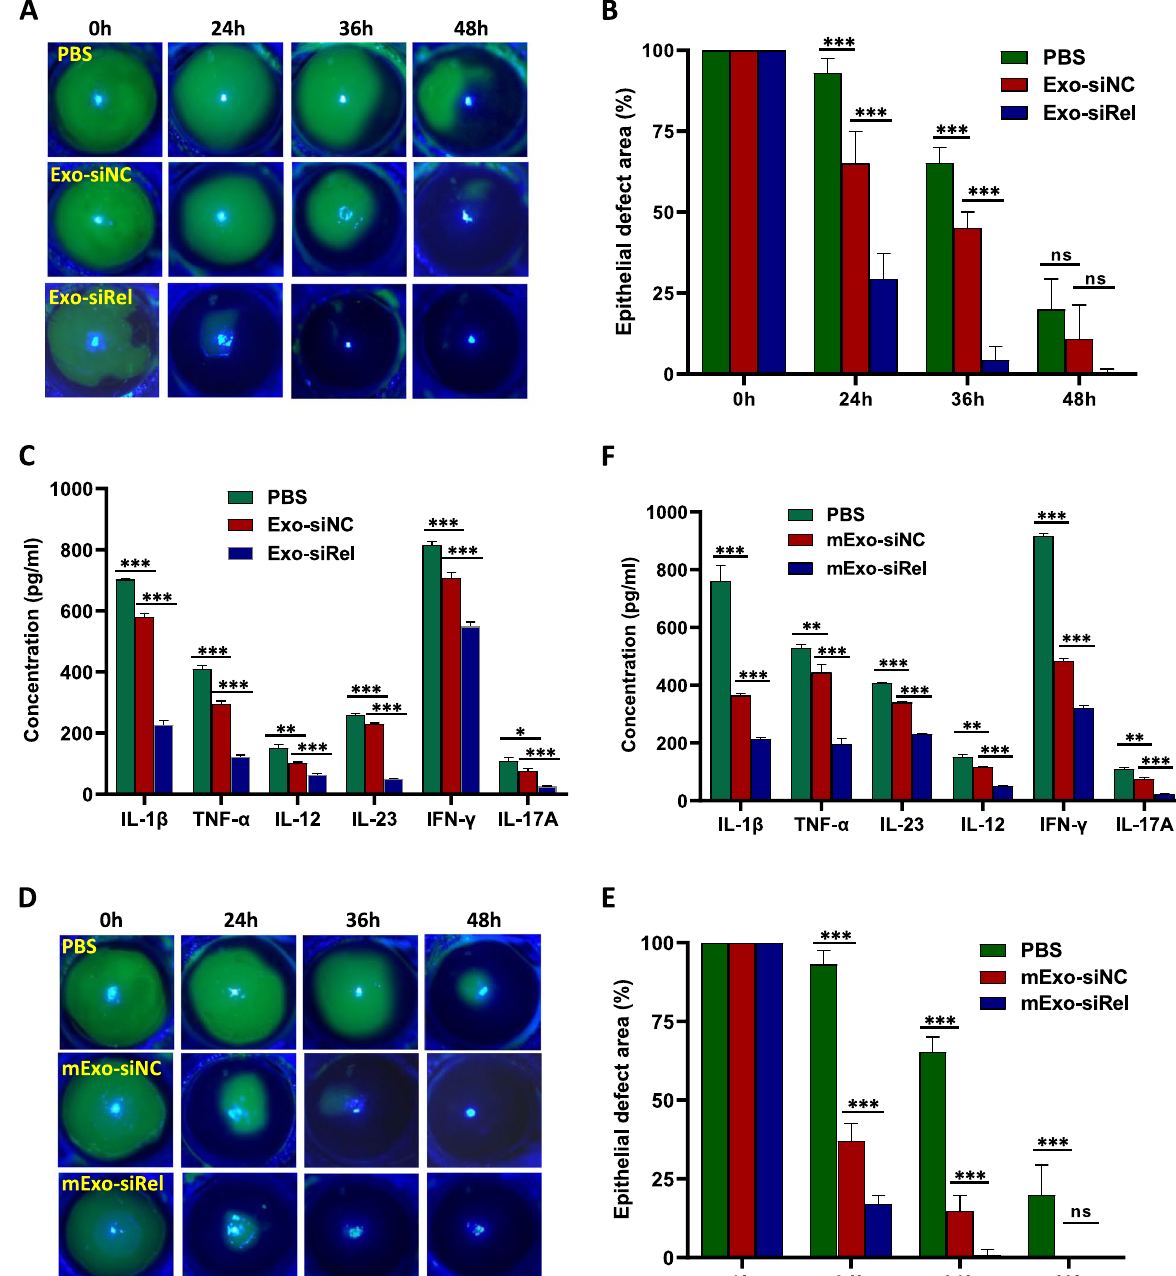
Fig. 5 Topical treatment on the corneal surface with siRel-loaded exosomes displays superior efficacy in accelerating diabetic corneal wound healing. A corneal epithelial wound healing model was established in diabetic mice. A–C Exosomes were isolated from the supernatant of siNC ( n 6) or siRel-transfected ( n 6) hMSCs and topically applied to the corneal surface immediately after corneal epithelial scraping and at 12 h, 24 h, = = and 36 h hereafter. PBS-treated mice ( n 6) were used as control. Corneal epithelial wounds were stained with fluorescein sodium and examined = under a slit lamp microscope at the indicated time points ( A ). Statistical analysis was performed on the corneal epithelial defect area using Image J software ( B ). Corneal tissue extracts were prepared at 24 h after corneal epithelial scraping and the production of inflammatory cytokines as indicated in the figure was determined by ELISA ( C ). D–F hMSC-derived exosomes were transfected with either siNC ( n 6) or siRel ( n 6) and = = topically applied to the corneal surface as described in A–C . PBS-treated mice ( n 6) were used as control. Corneal epithelial wound staining = ( D ), statistical analysis of corneal epithelial defect area ( E ), and detection of inflammatory cytokine production in corneal extracts ( F ) were then performed also as described in A–C . For A , C , D , and F , results shown are representative of two independent experiments. For B and E , results shown are combined from two independent experiments. * P <0.05, ** P <0.01, *** P